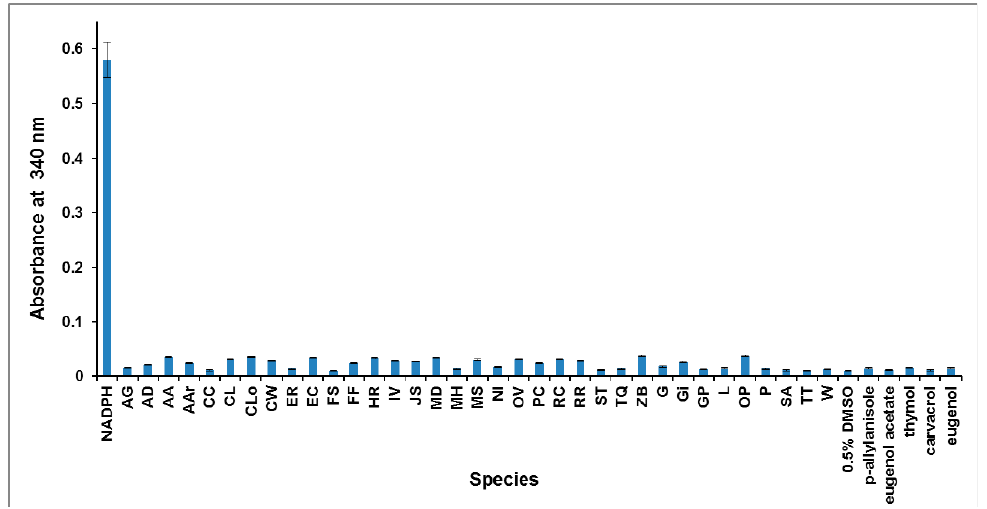
Figure 2. The UV absorbance of NADPH, plant essential oils (Eos), individual EO components, and DMSO at 340 nm. NADPH (0.15 mM in 100 mM Tris-HCl, pH 7.4); Plant EOs and individual EO component at 50 μ g/mL in methanol; DMSO at 0.5% in water.